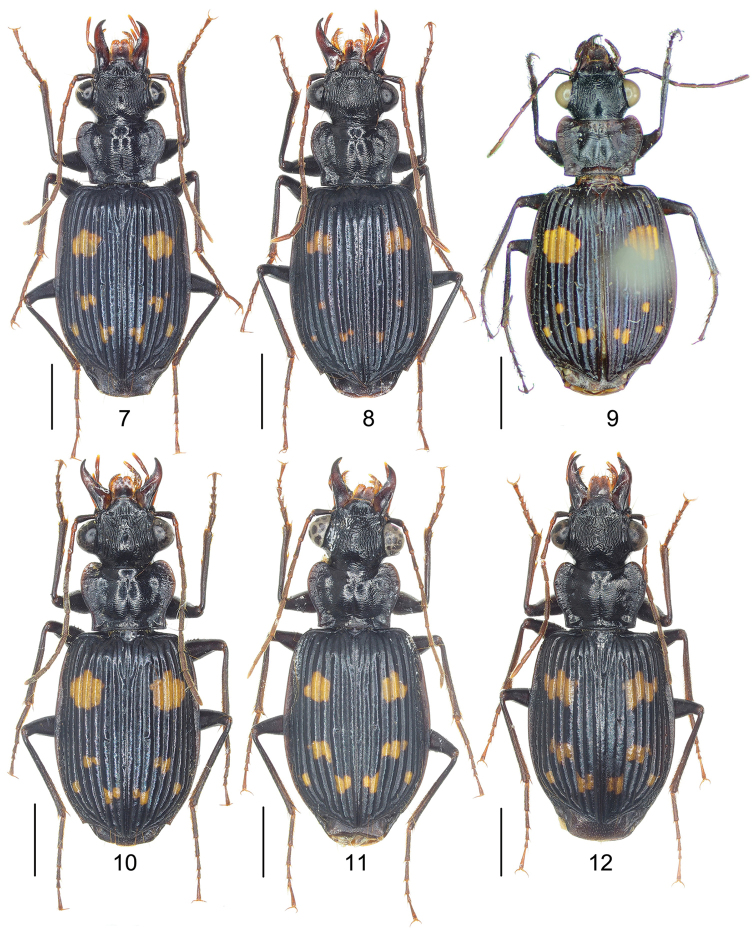
Habitus 7
P.
acutidens sp. n., holotype, Yunnan (Longchuan), male 8
P.
acutidens sp. n., paratype, Myanmar (Putao), female 9
P.
ornatus
ornatus Schmidt-Göbel, syntype, Myanmar (Tenasserim), male 10
P.
ornatus
ornatus Schmidt-Göbel, Yunnan (Hekou), male 11
P.
ornatus
ornatus Schmidt-Göbel, Hainan (Baisha), male; 12
P.
ornatus
formosanus Dupuis. Taiwan (Yilan), female. Scale bars: 2 mm.